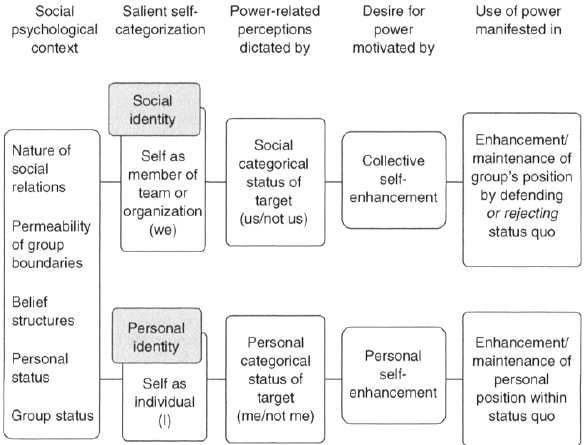
Fig. 2 The relationship between the optional quantity of psychological counselling terms and the intensity of self-consciousness